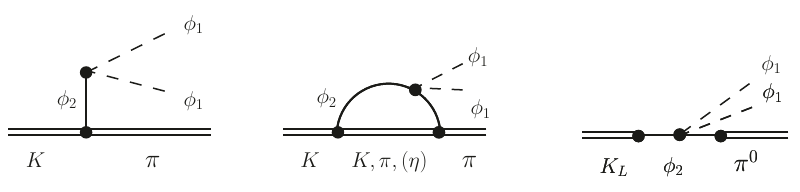
Figure 14 . The diagrams inducing the K shown in eqs. (4.3) and (4.4). The 3rd diagram violates the GN